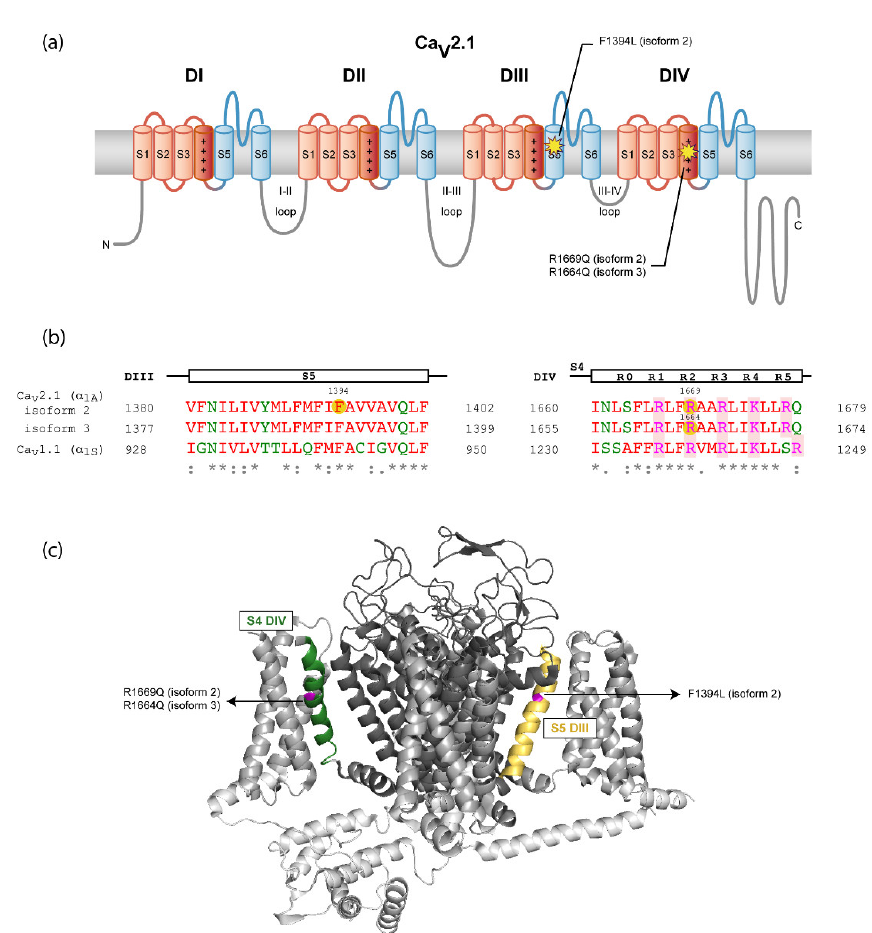
Figure 2. Location of the mutations in Ca V 2.1 α 1A channel subunit. ( a ) Location of the variant residues of α 1A channel subunit isoforms 2 and 3 in the secondary structure of the protein according to the cryo-electron microscopy (cryo-EM) structure of the rabbit Ca V 1.1 complex, containing the pore-forming α 1S and several regulatory subunits [12] (see also panel B). N- and C-termini and the intracellular loops are shown in gray, voltage-sensor modules (S1–S4) from the four domains are in red—with the S4 α -helixes colored in dark red—and Ca 2+ -selective pore modules (S5-P loop-S6) are in blue. ( b ) Sequence alignment of the regions affected by variants between the human α 1A subunit isoforms 2 and 3 and rabbit Ca V 1.1 α 1S subunit. The α 1A subunit segment of each alignment is indicated at the top. Mutations are highlighted with yellow circles on the human Ca V 2.1 (hCa V 2.1) sequences. The gating charged residues of S4 segments (labeled R0-R5) are shaded in red. Amino acids are colored depending on their physicochemical properties: small and hydrophobic are in red, acidic in blue, basic in magenta and G and amino acids containing hydroxyl, sulfhydryl or amine groups in green. Below, a consensus code indicates fully conserved residues (*), conservation between residues with strongly similar properties (:) or with weakly similar properties (.). The Uniport IDs of the sequences aligned are for hCa V 2 ( α 1A ): O00555-2 (isoform 2) and O00555-3 (isoform 3) and for rabbit Ca V 1.1 ( α 1S ): P07293. The sequence alignments were made using Multiple Sequence Aligment Clustal Omega. ( c ) Three-dimensional location of the amino acid variants on a Ca V channel model. The structure of the α 1S subunit of the Ca V 1.1 channel (PDB 5GJV) [12] was used as a model considering their high level of homology (panel B). N- and C-termini and the intracellular loops are shown in light gray, voltage-sensor modules (S1–S4) are in gray and Ca 2+ -selective pore modules (S5-P loop-S6) are in dark gray. The two regions where mutations are located are highlighted in yellow for S5 helix of DIII and green for S4 helix of DIV. The residues of Ca V 1.1 ( α 1S ) equivalent to those mutated in Ca V 2.1 ( α 1A ) and identified in the patients, according to the sequence alignment on panel B, have been highlighted in